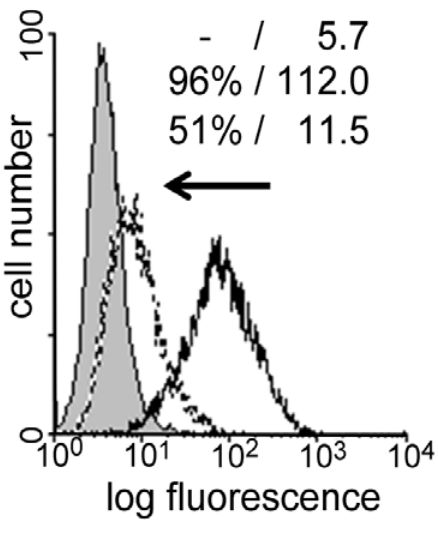
Figure 2. Schematic illustration of the principle of the experimental read-out in cytofluorometric analysis of glycocluster activity. When a labeled lectin binds to cell surfaces, the signal (in percentage of positive cells and mean fluorescence intensity) describes the cells’ reactivity (black line). The presence of an inhibitor reduces staining (dotted line), shifting the binding profile into the direction of the background value (grey